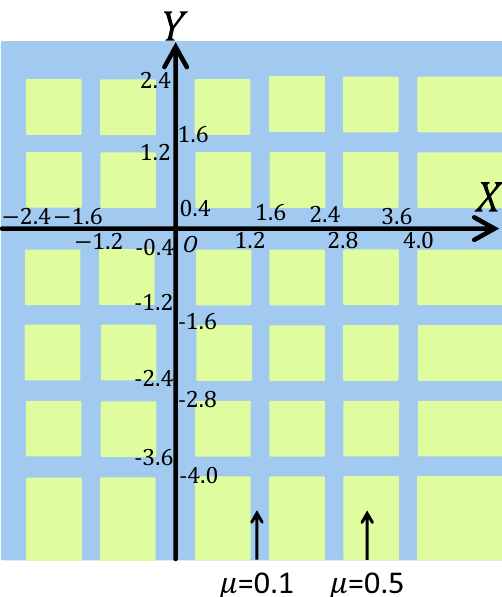
Figure 2. Definition of the static friction coefficient between the ground and the passive wheel. The set meshed pattern friction coefficients resulted in the generation of side-slipping in an unexpected fashion.